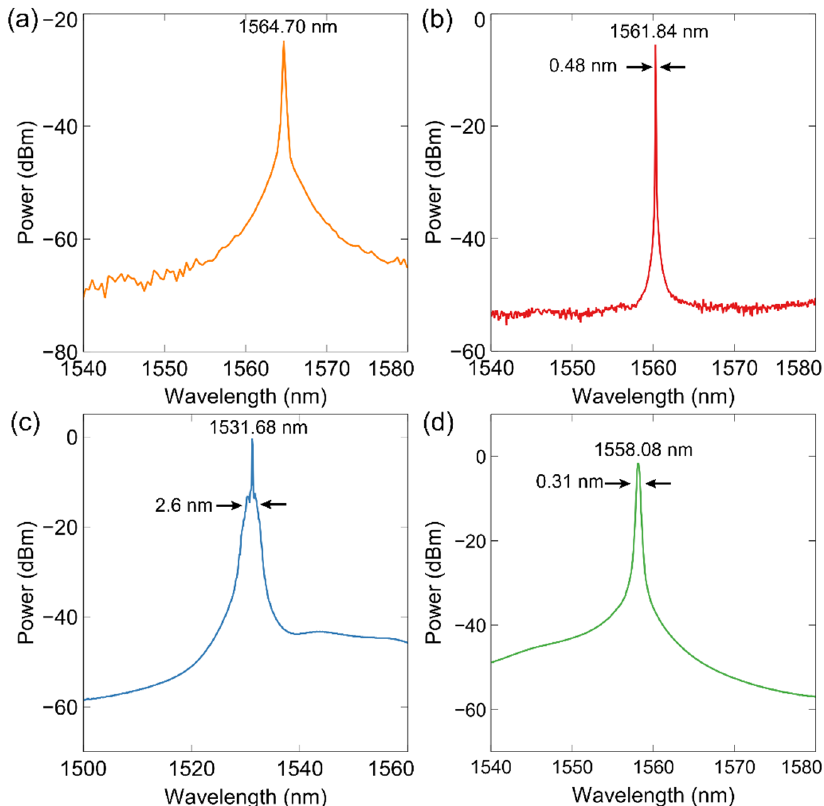
Figure 11. Optical spectrum trace from OSA at maximum pump power for ( a ) continuous wave, ( b ) graphene-chitin, ( c ) MoS 2 -chitin, and ( d ) graphene-MoS 2 -chitin.